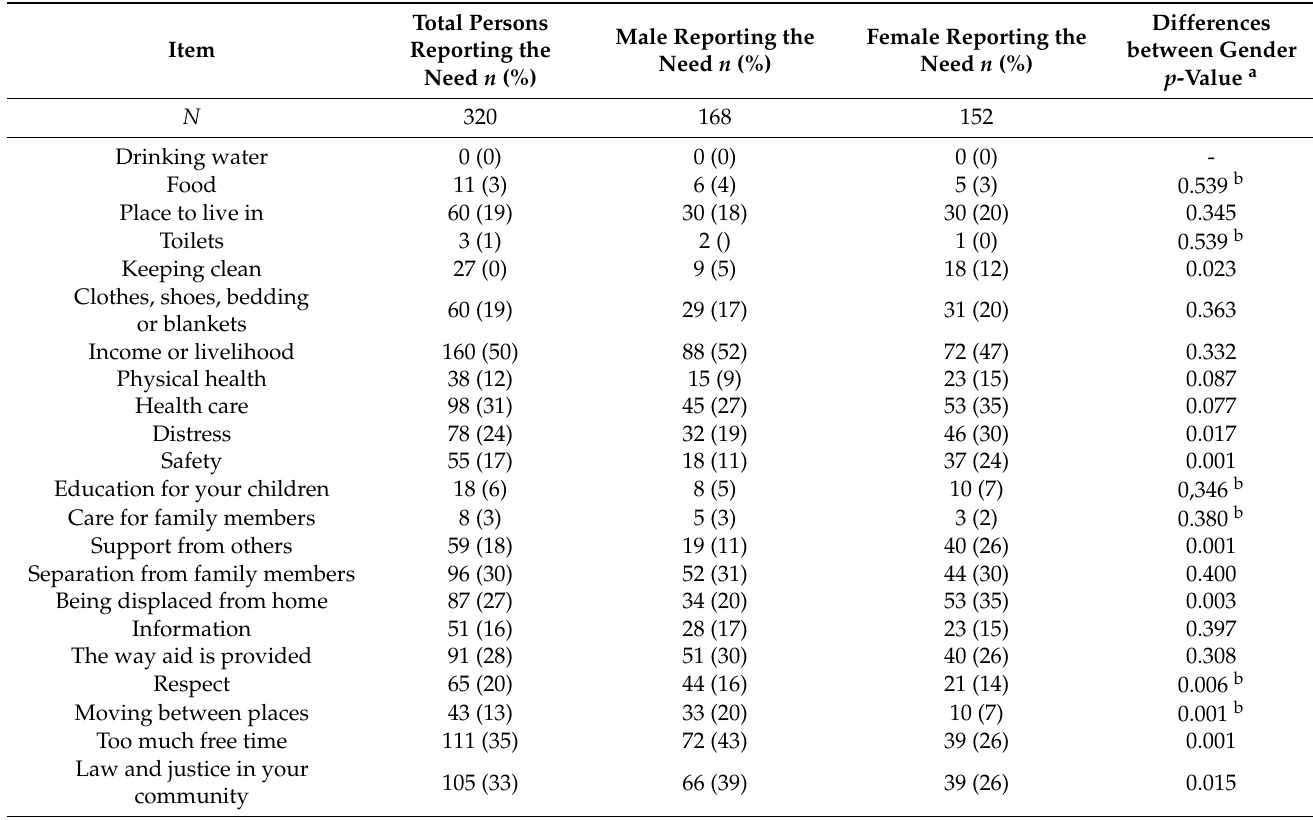
Table 5. Reported serious needs, item by